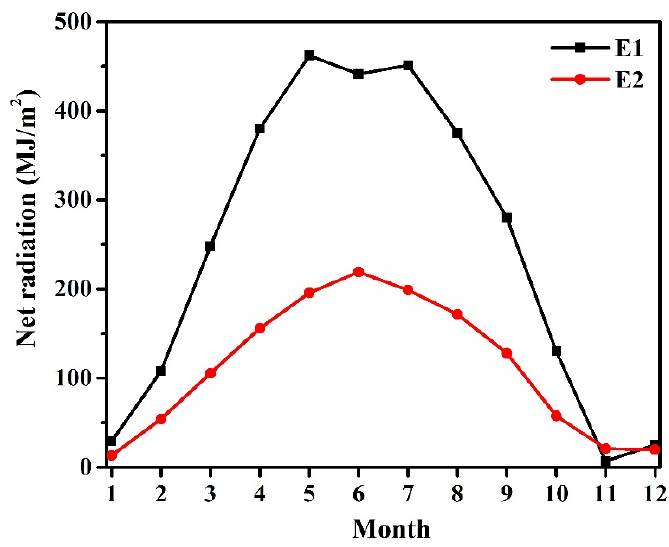
Figure 8. Seasonal net radiation of E1and E2 stations in BJD (Liang et al., 2020).